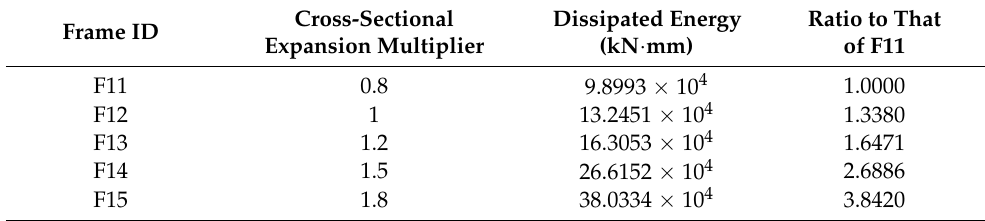
Figure 19. Hysteresis curves of the third group of frames: ( a ) F11; ( b ) F12; ( c ) F13; ( d ) F14; and ( e ) F15.